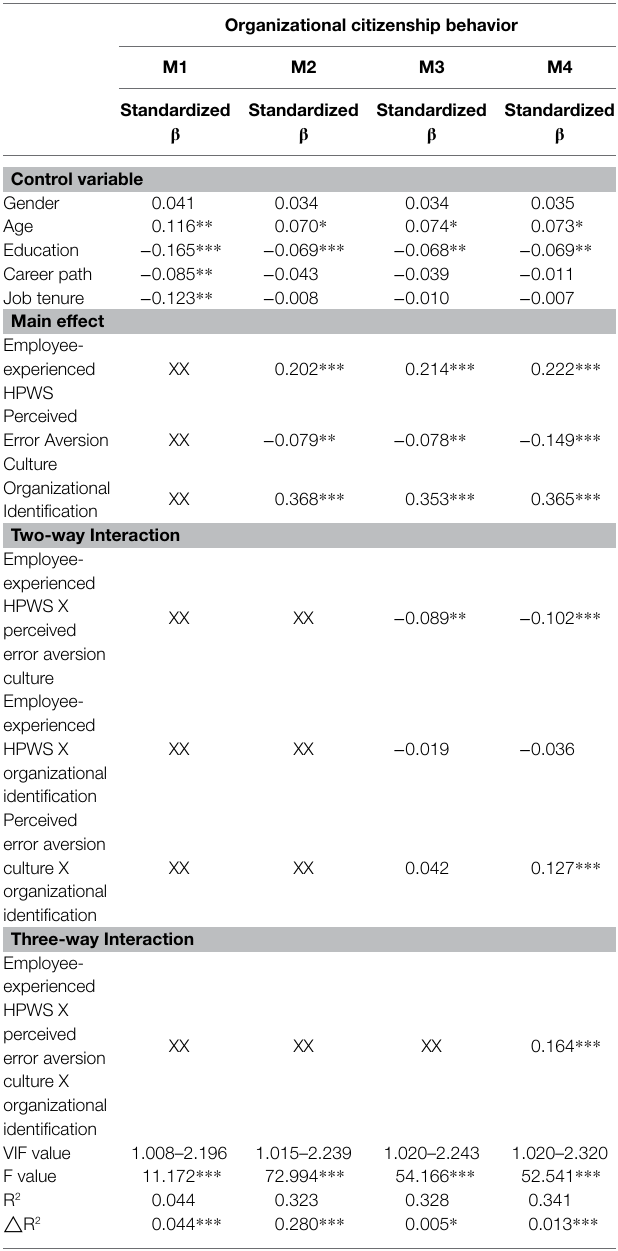
TABLE 4 | Effects of HPWS on OCB and the moderating role of perceived error aversion culture and organizational identification. Organizational citizenship